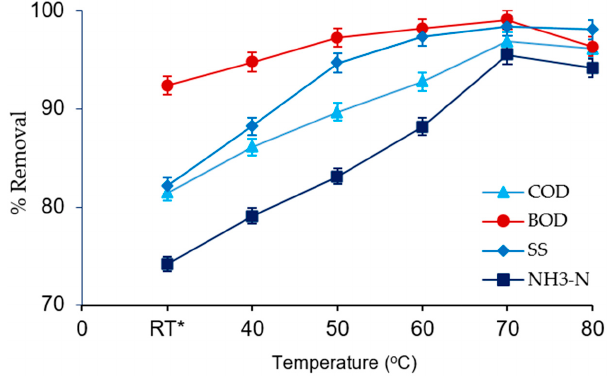
Figure 5. Influence of coagulant temperature on the removal of COD, BOD, SS, and NH 3 from SRPE using FeSO 4 ·7H 2 O as a coagulant. RT, room temperature. pH 5, doses 1 g/L, coagulation time 60 min, and sedimentation time 60 min.